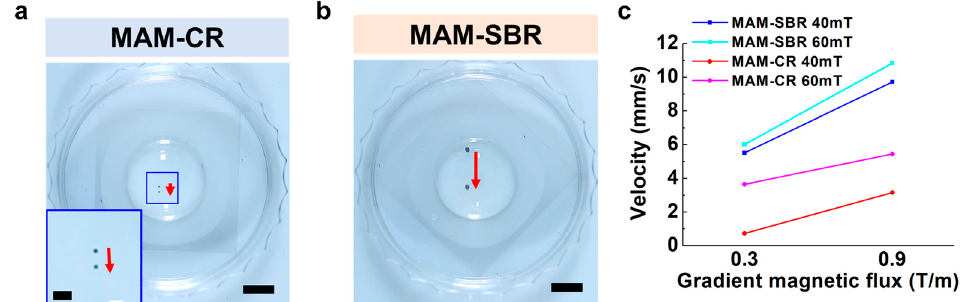
Figure 4. Magnetic actuation performance of the microscaffolds. Time-lapse images for the mobility of ( a ) MAM-CR and ( b ) MAM-SBR at different magnetic fields (40 mT) and gradients (0.3 T/m). The red arrows indicate the moving distances of the microscaffolds for one second. The scale bars are 5 mm. The blue boxes in ( a ) are shown as insets. The scale bar of the inset images is 1 mm. ( c ) Graph for mobilities of MAM-CR and MAM-SBR at different magnetic fields (40 and 60 mT) and gradients (0.3 and 0.9 T/m).